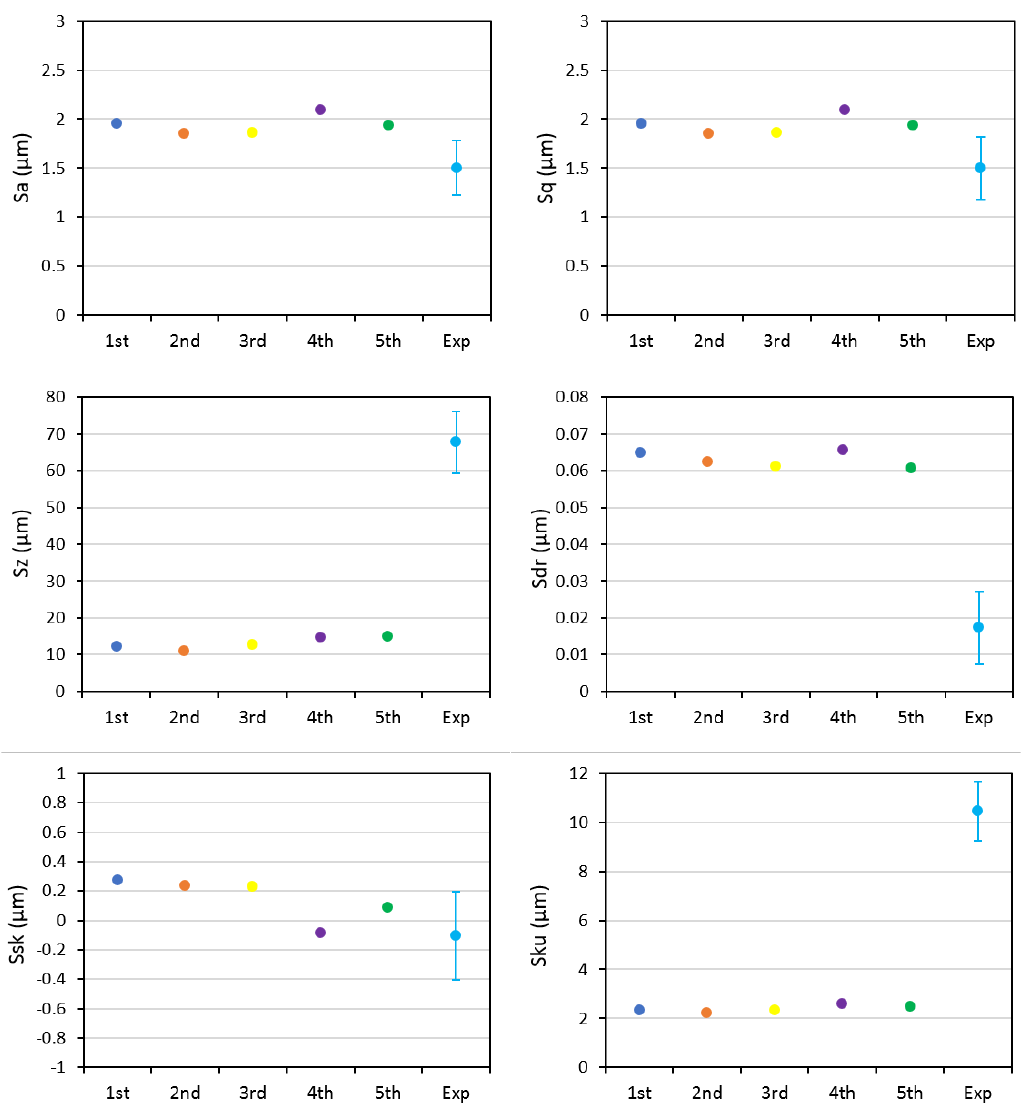
Figure 3. Comparison of areal parameters obtained from five different simulations and the experimental results for full coverage.